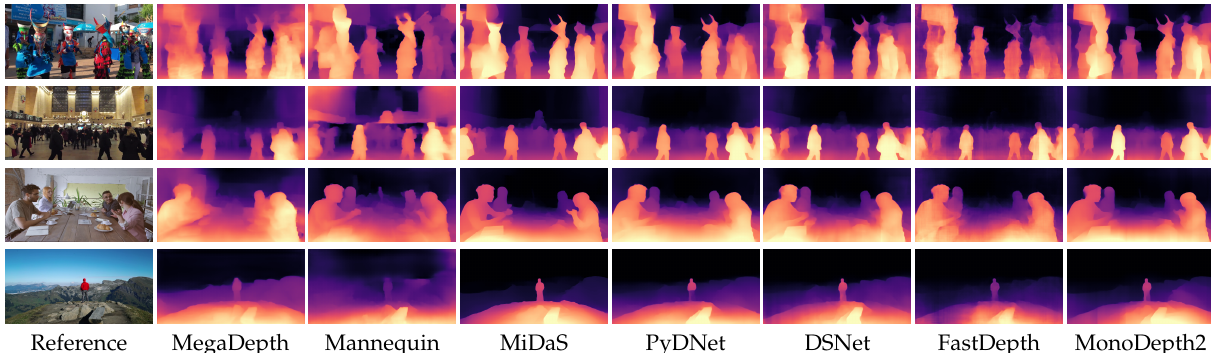
Figure 4. Qualitative results from Internet photos. From left to right, the reference image from Pexels website, and depths from MegaDepth [54], Mannequin [35], MiDaS [17], PyDNet, DSNet, FastDepth and MonoDepth2.